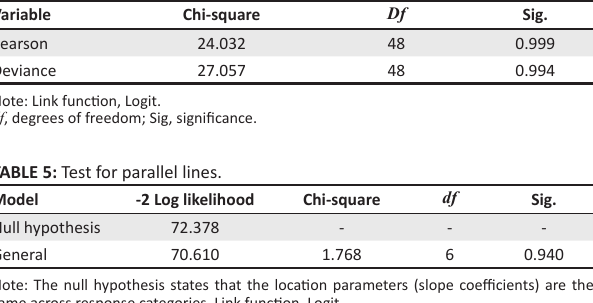
TABLE 4: Proportional odds chi-square